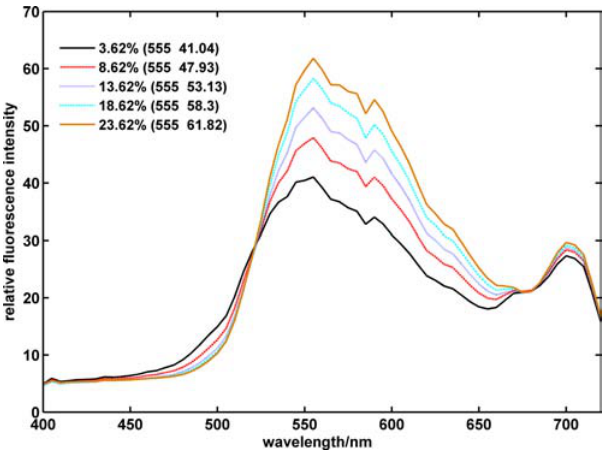
Fig. 6. The relative °uorescence intensity for the self-made CBT with di®erent mass percentages of BH. The numbers in the brackets show that the maximal °uorescence appears at 555 nm.